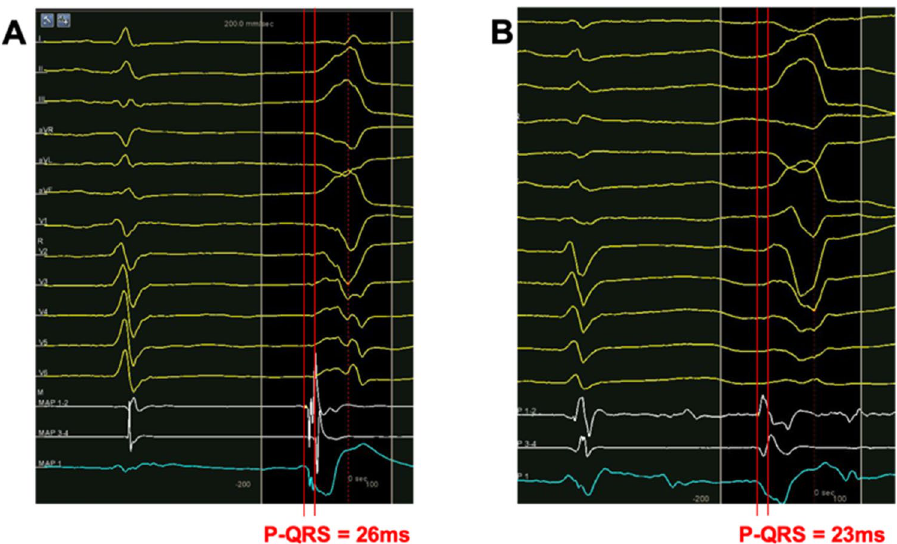
Figure 2. Bipolar and unipolar electrogram at the site with earliest activation time below PV. ( A ) The point with special potential, ( B ) the point without special potential. In both figures, bipolar electrograms of distal pair were presented as the upper white line.